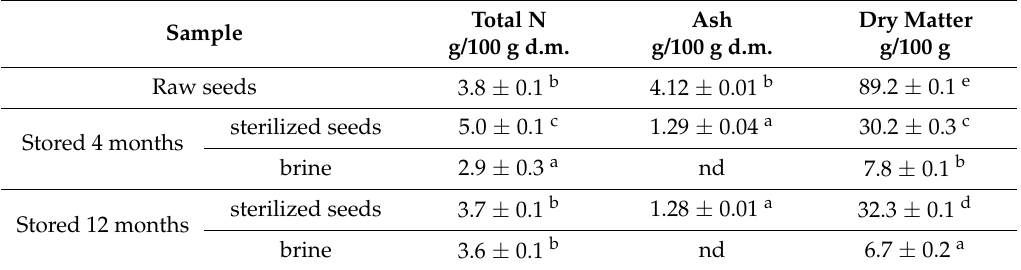
Table 1. Characterization of raw and processed material (nd—not